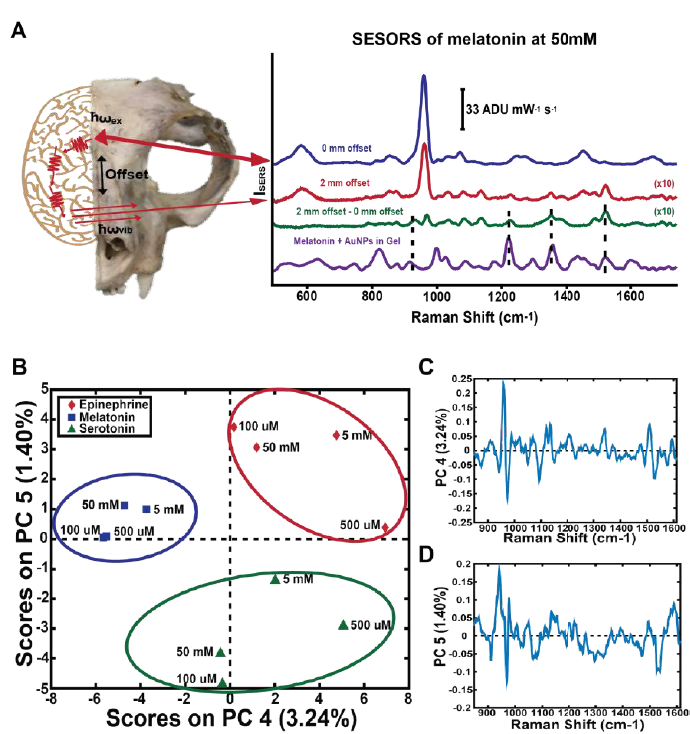
Figure 2. Raman scattered light was collected at a point spatially offset from the incident illumination point, allowing the signal from the neurotransmitter to be acquired through a cat skull ( A ). PCA was used to show that the individual neurotransmitters are clearly separated from each other in a plot of the scores of PC4 versus PC5 ( B ) and their corresponding loadings ( C , D ). Adapted with permission